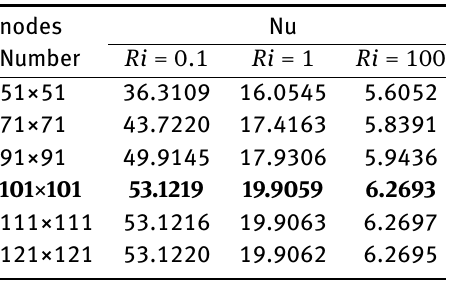
Table 3: Average Nusselt number of the Cu-water nanofluid for dif- ferent uniform grids. ϕ = 0.02 , Pr = 6.2